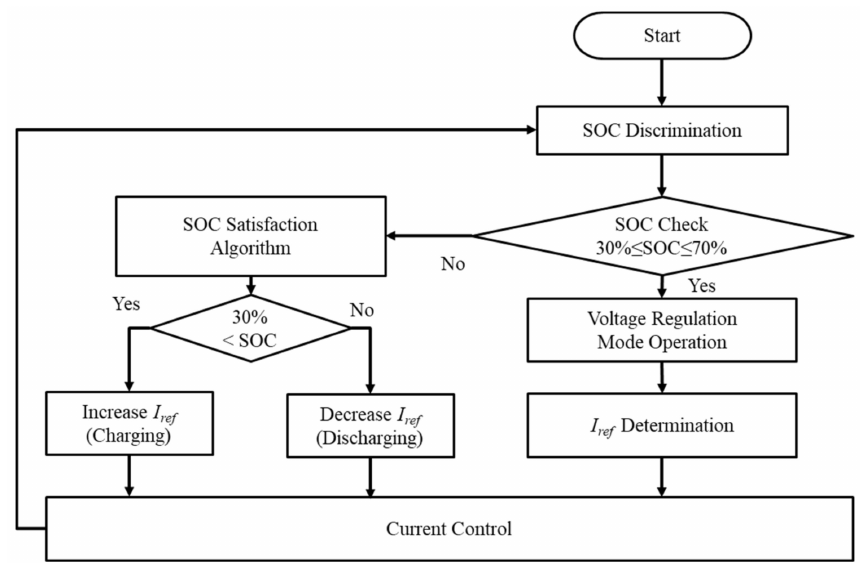
Figure 8. Prior SoC satisfaction algorithms of the distributed ESSs.